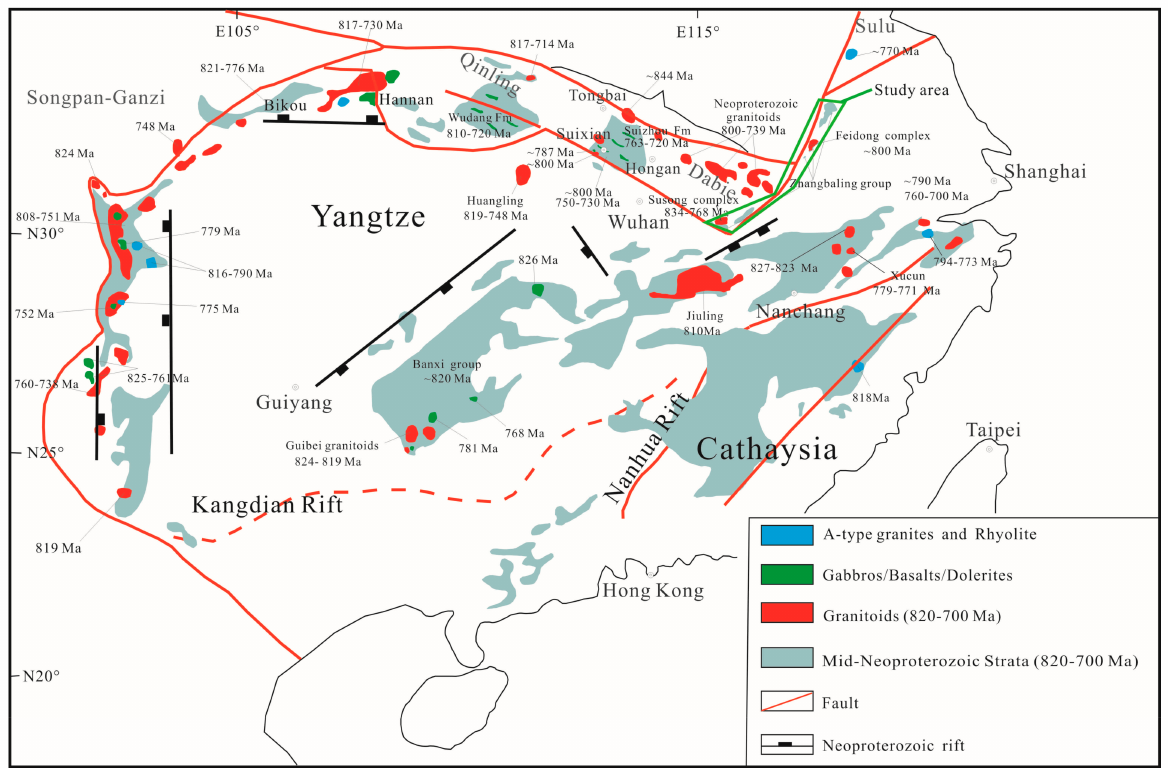
Figure 8. Distribution of Neoproterozoic rocks in south China modified after